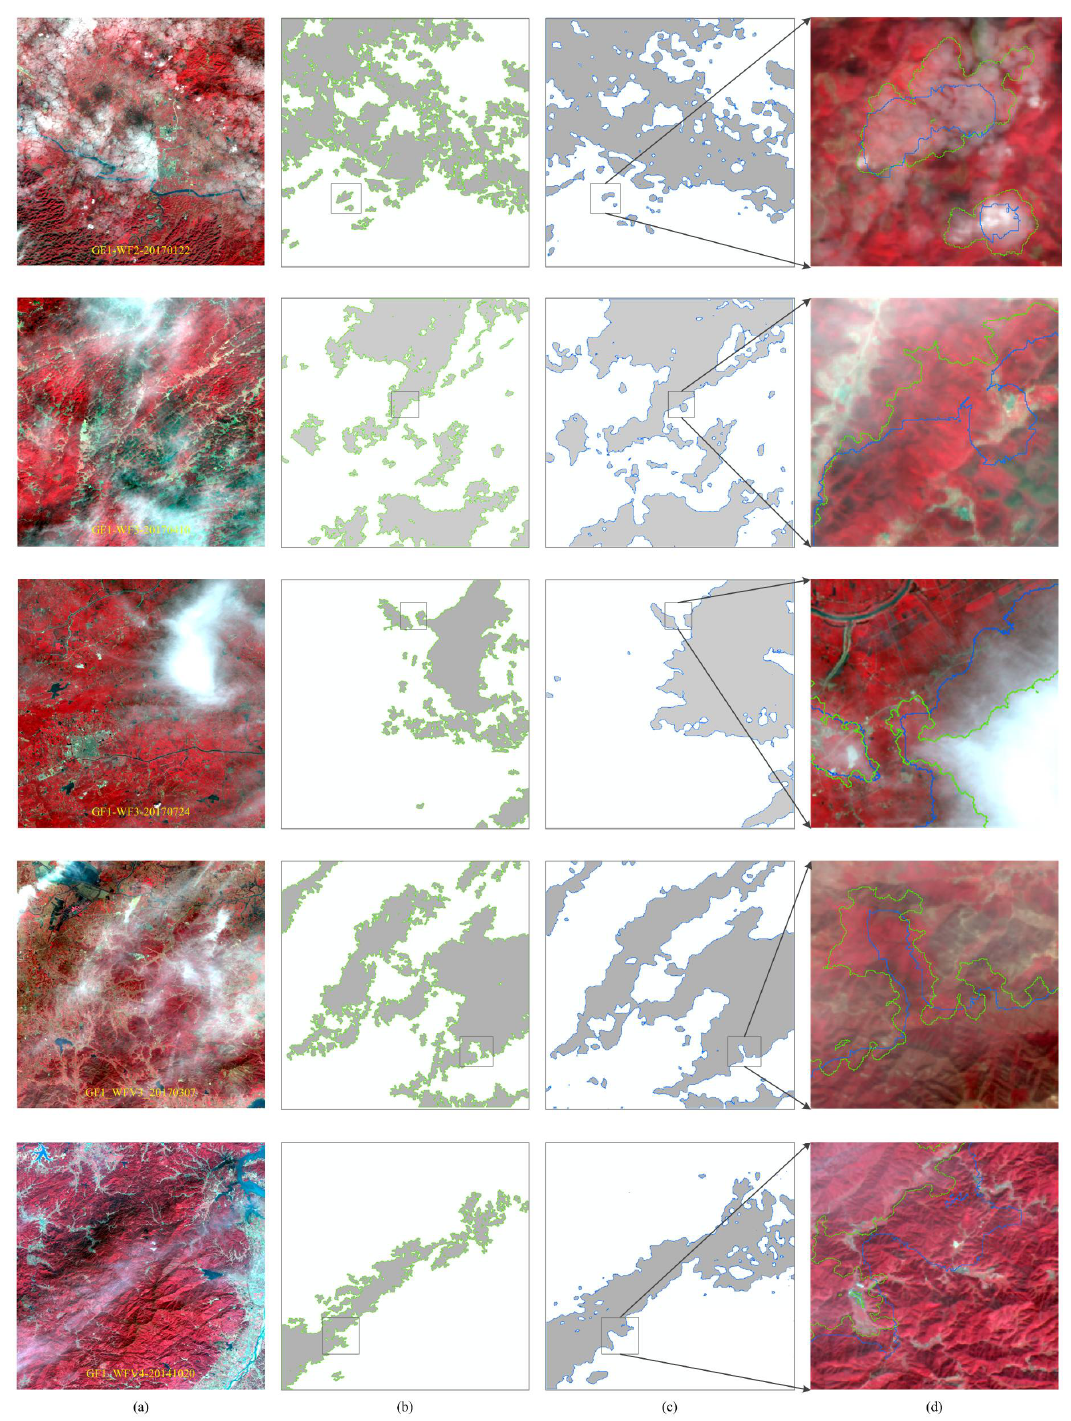
Figure 5. Thin-cloud mask results of the Wide Field View (WFV) onboard the Gao Fen 1 (GF1). Column ( a ) is the original image; column ( b ) shows the cloud mask results using our method; column ( c ) shows the results from contrasting methods; and column ( d ) shows the magnified cloud mask results of the local area, where the blue line represents the contrasting results and the green line represents our method’s results.